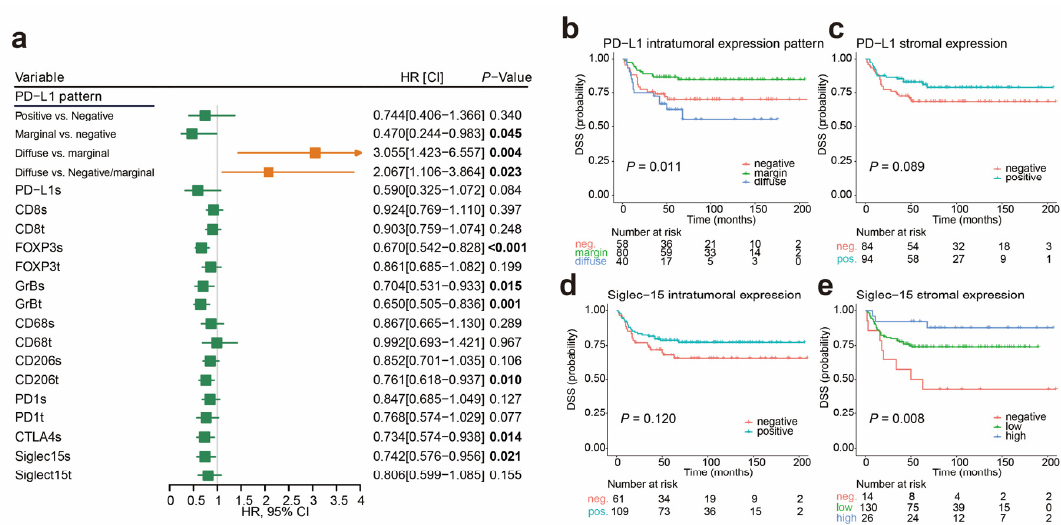
Figure 3. The correlation of patient prognosis and expression of immune markers in peSCC. ( a ) The densities of immune markers were treated as continuous variables. Forest plot shows the hazard ratios (HR) for disease-specific survival (DSS). Values shown in bold are statistically significant. ( b – e ) Kaplan–Meier survival analyses (log-rank tests) were conducted, according to PD-L1 expression in tumor ( b ), PD-L1 expression in stroma ( c ), Siglec-15 expression in tumor ( d ), and Siglec-15 expression in stroma ( e ).